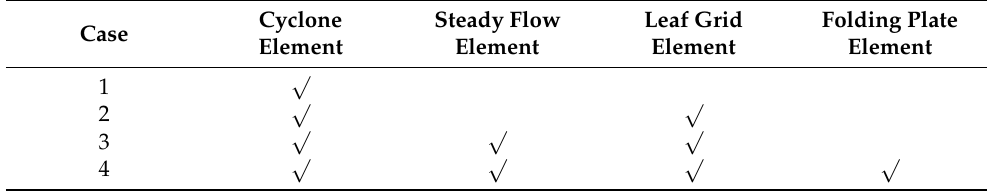
Table 2. Experimental case